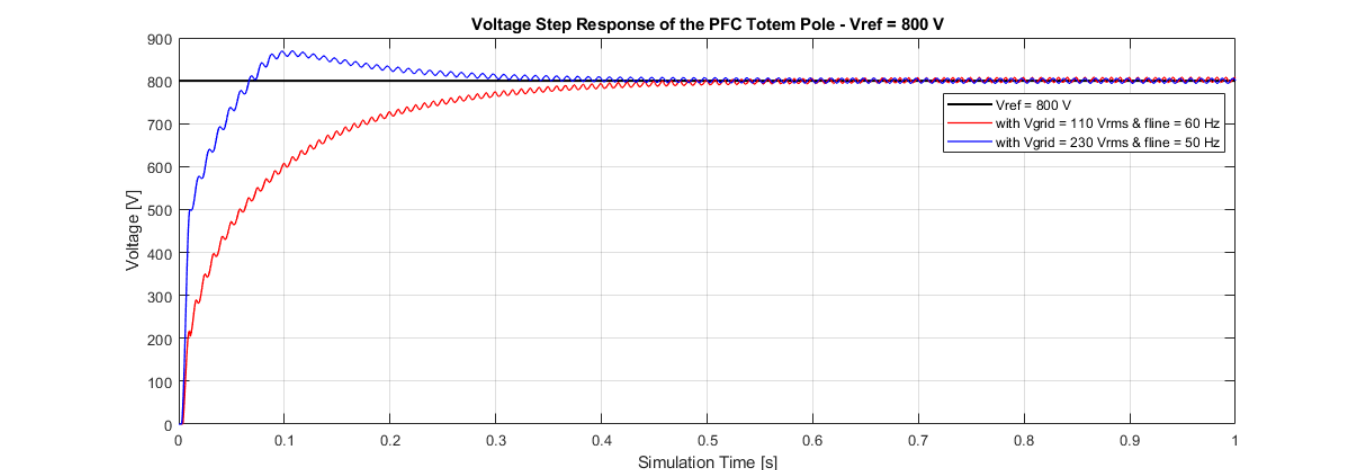
Figure 16. Voltage control of the Totem Pole with V ref = 700 V.